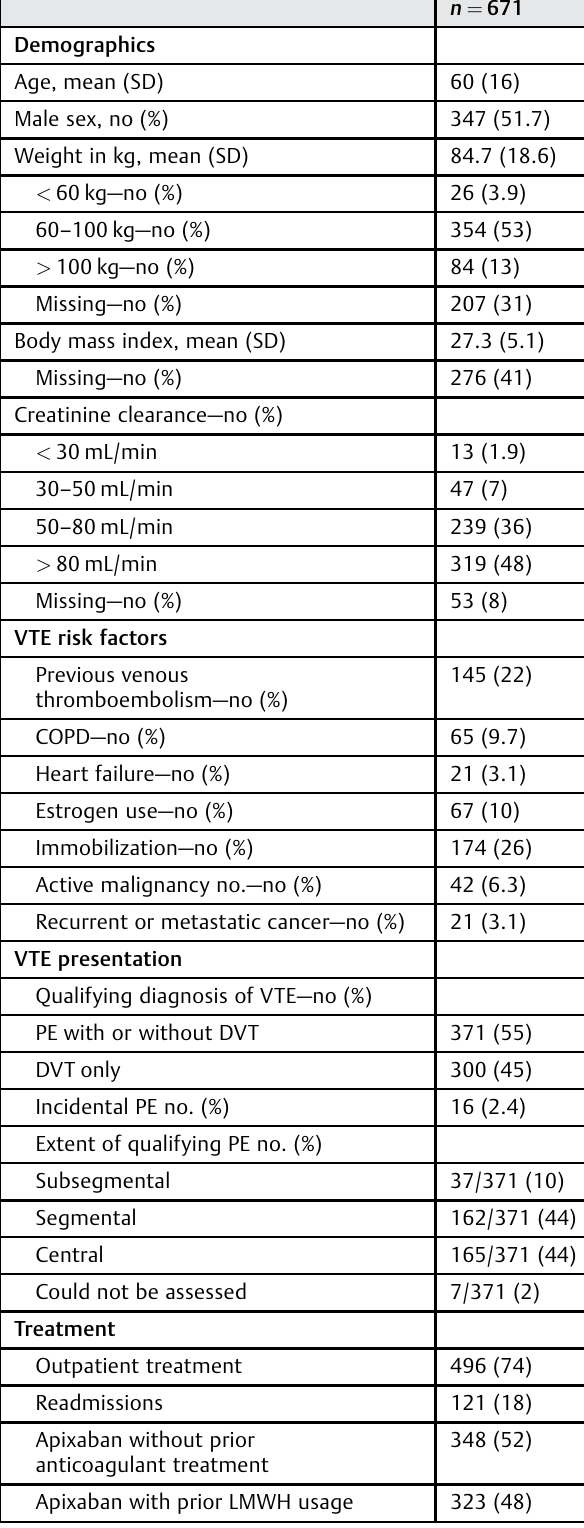
Table 1 Baseline characteristics of patients with VTE treated with apixaban